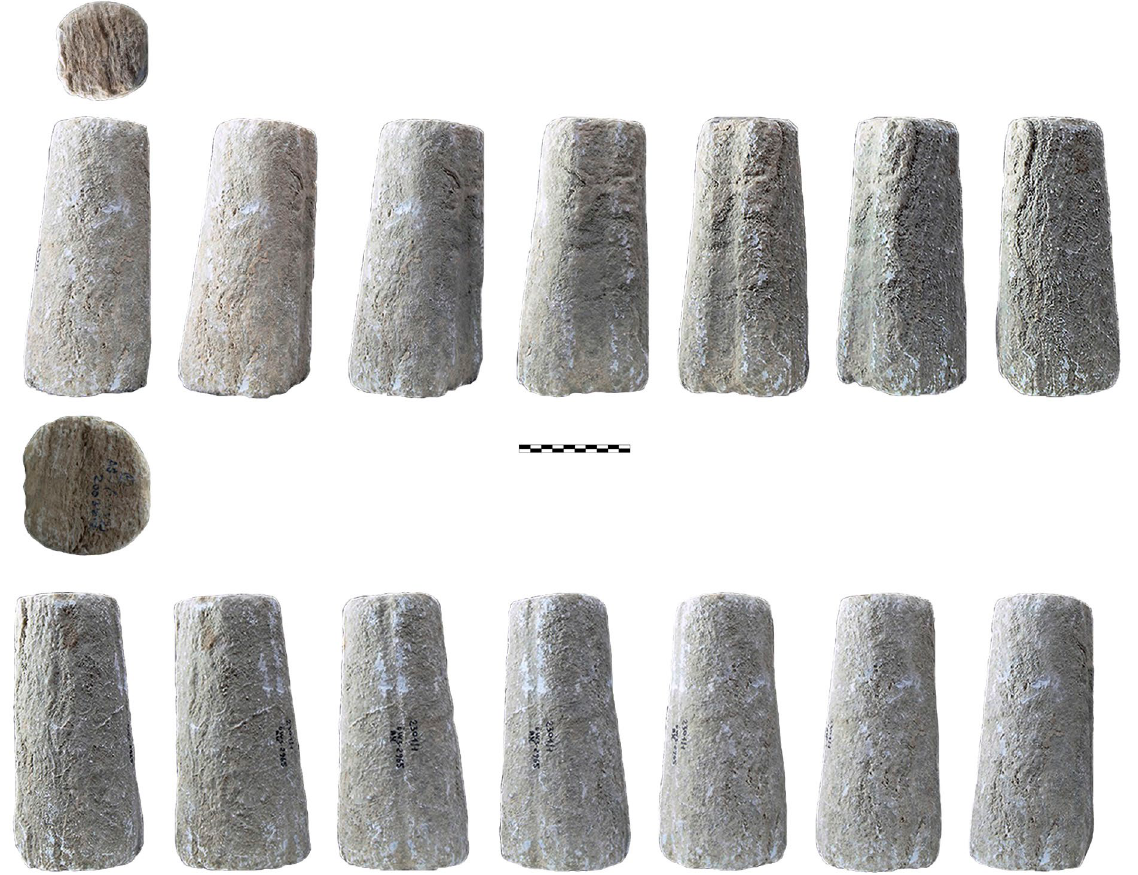
Figure 4. The principle of photofixation of a miniature column. Adjikui Depe (from the depositories of the National Museum of Turkmenistan, Ashgabat). Scale bar is 10 cm long, separated into three 1 cm